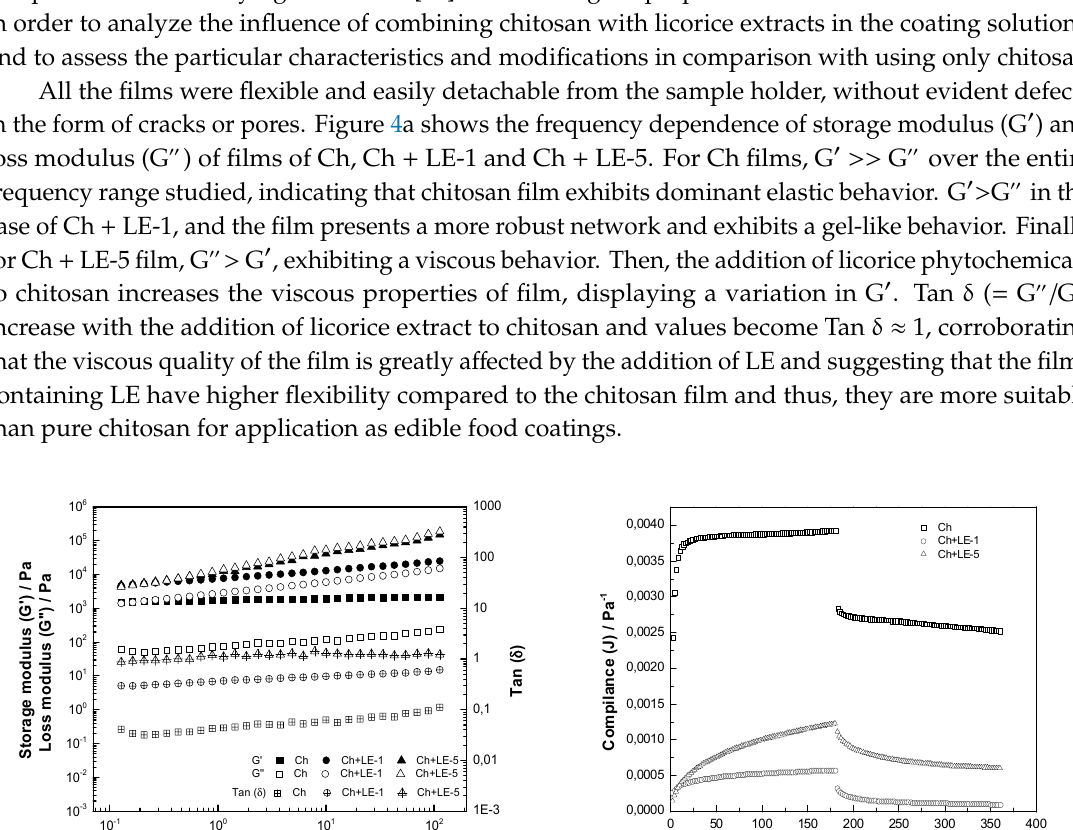
Table 5. Burger model parameters obtained for the films. Ch = Chitosan; Ch + LE-1 = Chitosan + 1% of licorice extract; Ch + LE-5 = Chitosan + 5% of licorice extract.